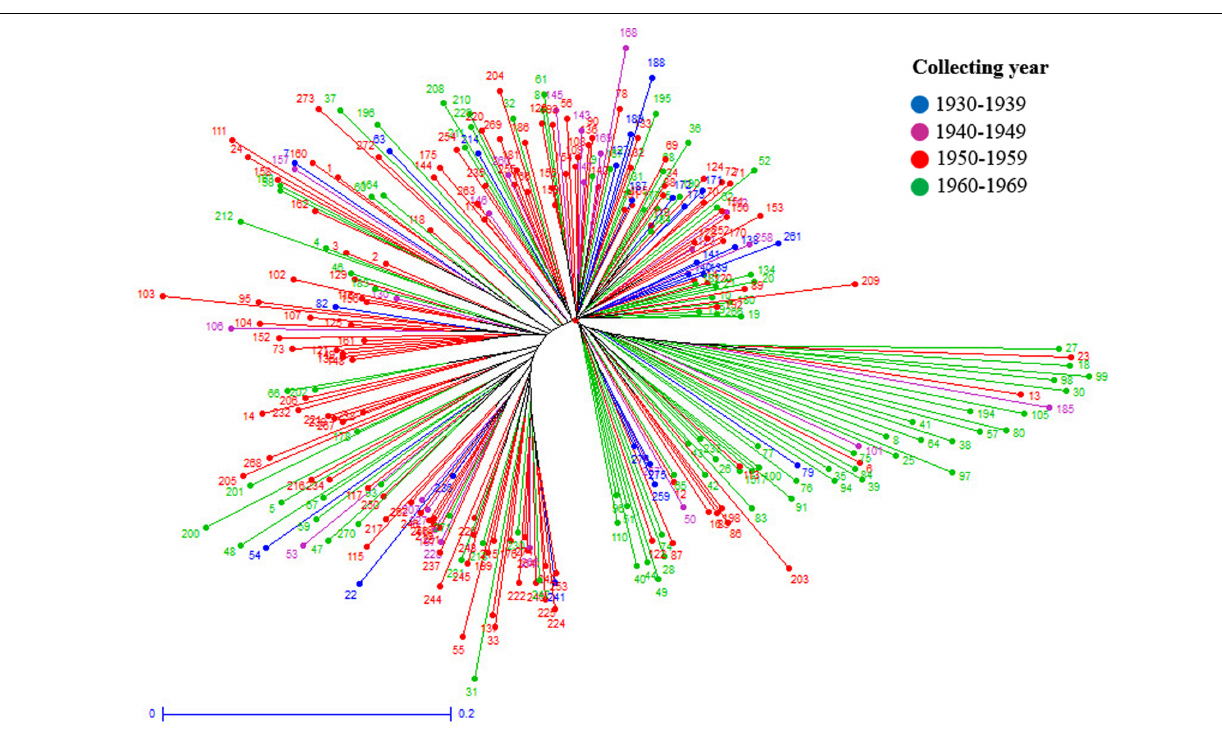
was much higher than that from CSSS assembly (5.5